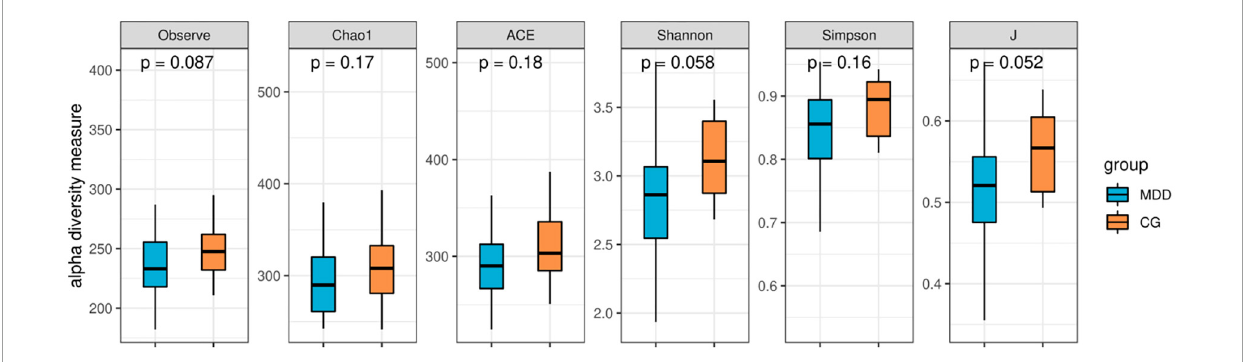
FIGURE3 Box plot of α diversity